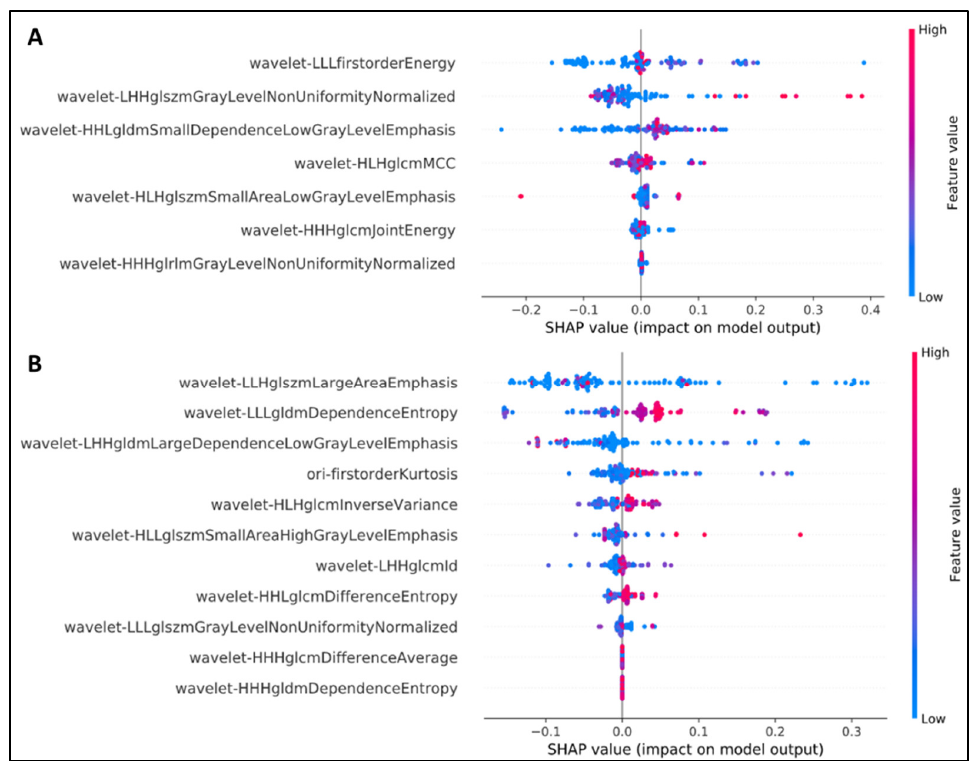
Figure 2. SHAP analysis to explain the crucial features of our NSCLC radiogenomics models. ( A ) EGFR mutation status, ( B ) KRAS mutation status.